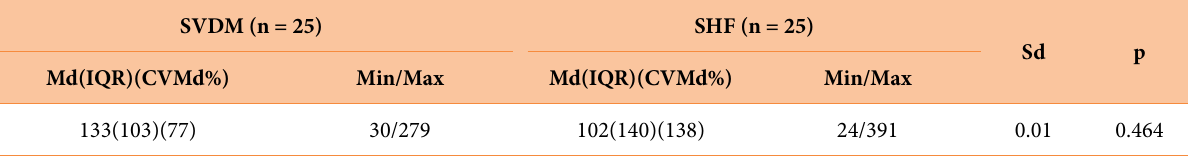
Table 3). SAH (SVDM: 32%, SHF: 48%) and DM (SVDM: 28%, SHF: 48%) were the comorbidities most associated with injuries (Table 4). Table 2 - Wound areas (cm 2 ).